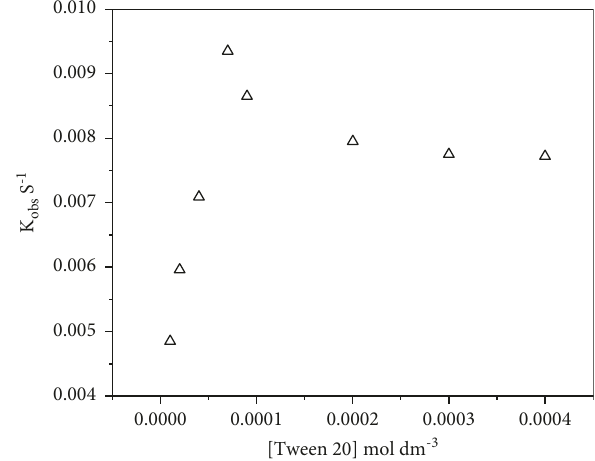
Figure 9: k obs vs. [Tween 20], at the following reaction conditions: [Maltose] � 0.030moldm − 3 , [Ce (IV)] � 0.0030moldm − 3 , and [H 2 SO 4 ] � 0.40 moldm − 3 at 293K.